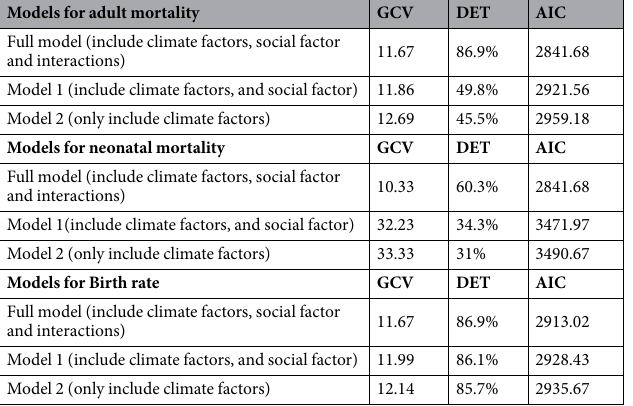
Table 2. Goodness-of-Fit of Models for Three Population Demographic Metrics. Note: AIC indicates Akaike information criterion (smaller for better model), GCV stands for generalized cross validation score (smaller for better model), and DEC denotes coefficient of determination (larger for better